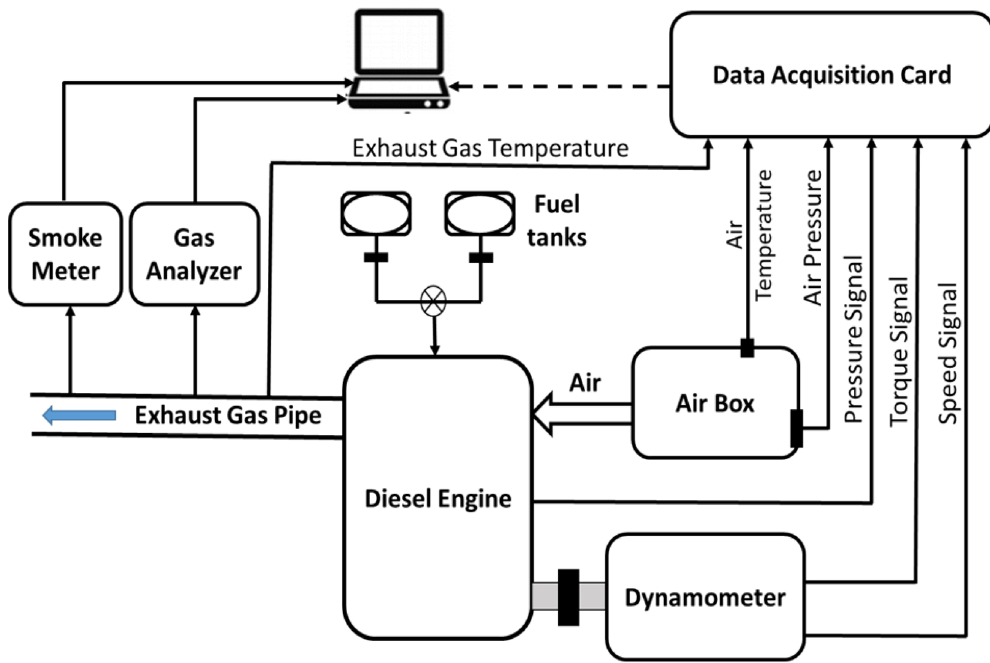
Figure 2. Schematic of the experimental